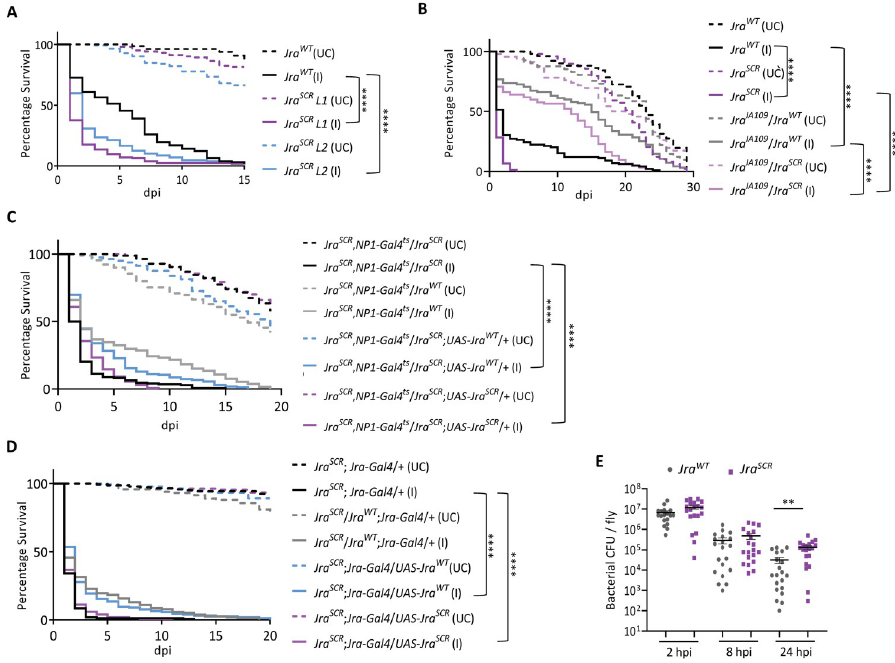
Fig 5. Survival curves post-infection suggest that Jra SCR is a hypermorphic allele. A. Survival curves of unchallenged (UC, dashed lines) and orally infected (I, closed lines), CRISPR/Cas9 modified Jra SCR flies, compared to Jra WT . L1 (red) and L2 (blue) indicate two independent Jra SCR lines used in the experiment. Log-rank test for trend was used to individually compare Jra SCR L1 (I) and Jra SCR L2 (I) to Jra WT (I). ���� p < 0.0001. B. Survival curves of UC (dotted) and I (closed), flies: Jra WT (black), Jra SCR (purple), Jra IA109 / Jra WT (grey) and Jra IA109 / Jra SCR (lavender). Log rank test for trend was used to compare Jra IA109 / Jra WT (I) to Jra WT (I), Jra IA109 / Jra SCR (I) to Jra SCR (I) and Jra IA109 / Jra SCR (I) to Jra IA109 / Jra WT (I). ���� p < 0.0001. C. Survival curves of UC (dotted) and I (closed) flies: Jra SCR , NP1-Gal4 ts / Jra SCR (black), Jra SCR , NP1-Gal4 ts / Jra WT (grey), Jra SCR , NP1-Gal4 ts / Jra SCR ; UAS-Jra WT /+ (blue) and Jra SCR , NP1-Gal4 ts / Jra SCR ; UAS-Jra SCR /+ (purple). Log rank test for trend was used to compare Jra SCR , NP1-Gal4 ts / Jra WT (I), Jra SCR , NP1-Gal4 ts / Jra SCR ; UAS-Jra WT /+ (I) and Jra SCR , NP1-Gal4 ts / Jra SCR ; UAS-Jra SCR /+ to Jra SCR , NP1-Gal4 ts /Jra SCR (I). ���� p < 0.0001. D. Survival curves of UC (dotted) and I (closed) flies: Jra SCR ; Jra-Gal4 /+ (black), Jra SCR / Jra WT ; Jra-Gal4 / + (grey), Jra SCR ; Jra-Gal4 / UAS-Jra WT (blue) and Jra SCR ; Jra-Gal4 / UAS-Jra SCR (purple). Log rank test for trend was used to compare Jra SCR / Jra WT ; Jra-Gal4 /+ (I), Jra SCR ; Jra-Gal4 / UAS-Jra WT (I) and Jra SCR ; Jra-Gal4 / UAS-Jra SCR to Jra SCR ; Jra- Gal4 /+ (I). ���� p < 0.0001. E. Scatter dot plot representing bacterial load as colony-forming units (CFUs) post oral feeding with Pe Student’s t-test was performed comparing Jra WT and Jra SCR at respective time point post-infection. �� p = 0.0015. Data related to the number of animals per experiment and replicates listed in S7A Fig . Data not significant is not represented